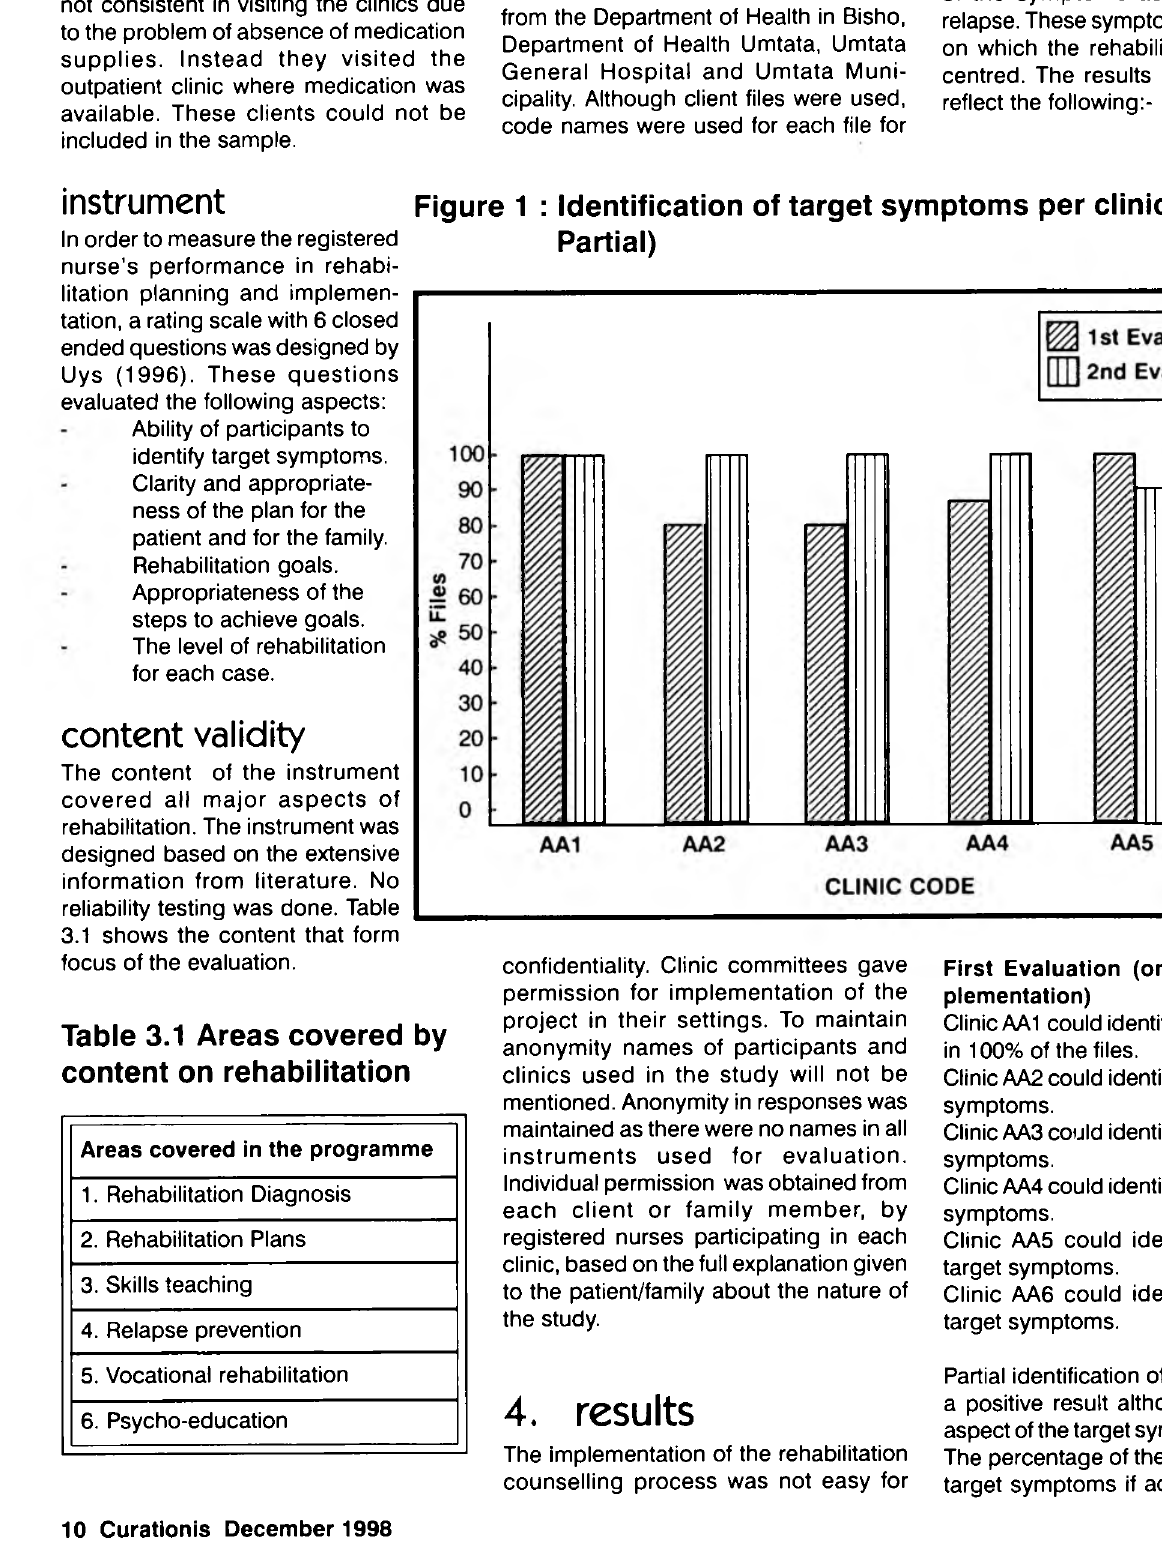
Figure 1 : Identification of target symptoms per clinic (Full